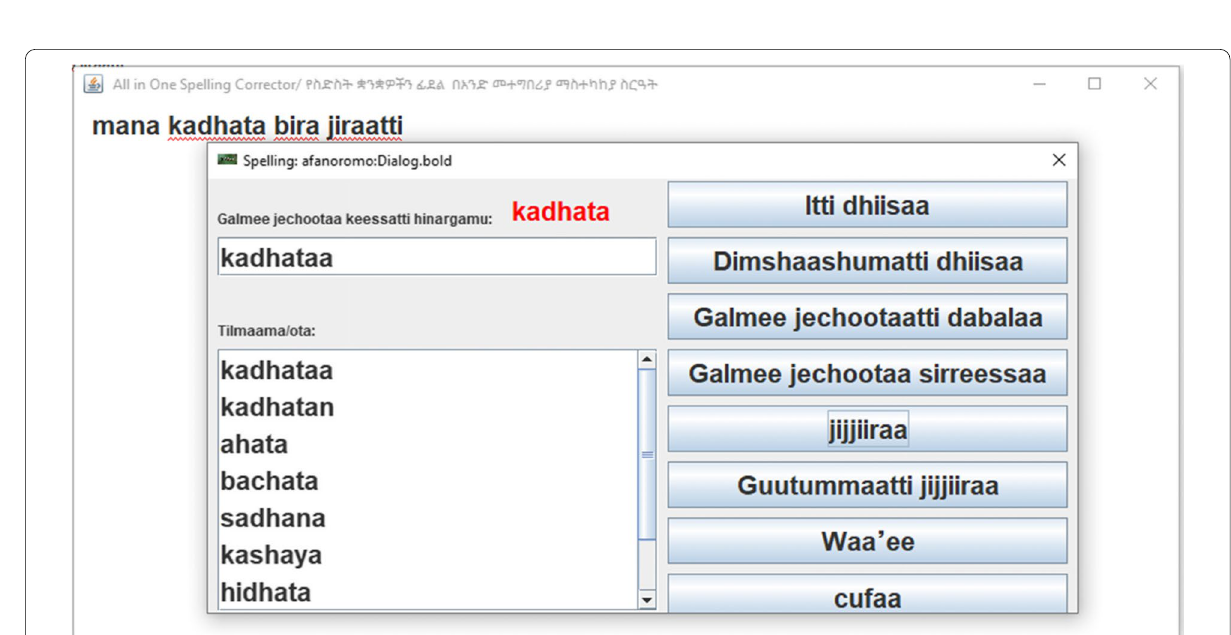
Fig. 11 Sample GUI for word suggestions from the Afan Oromo dictionary